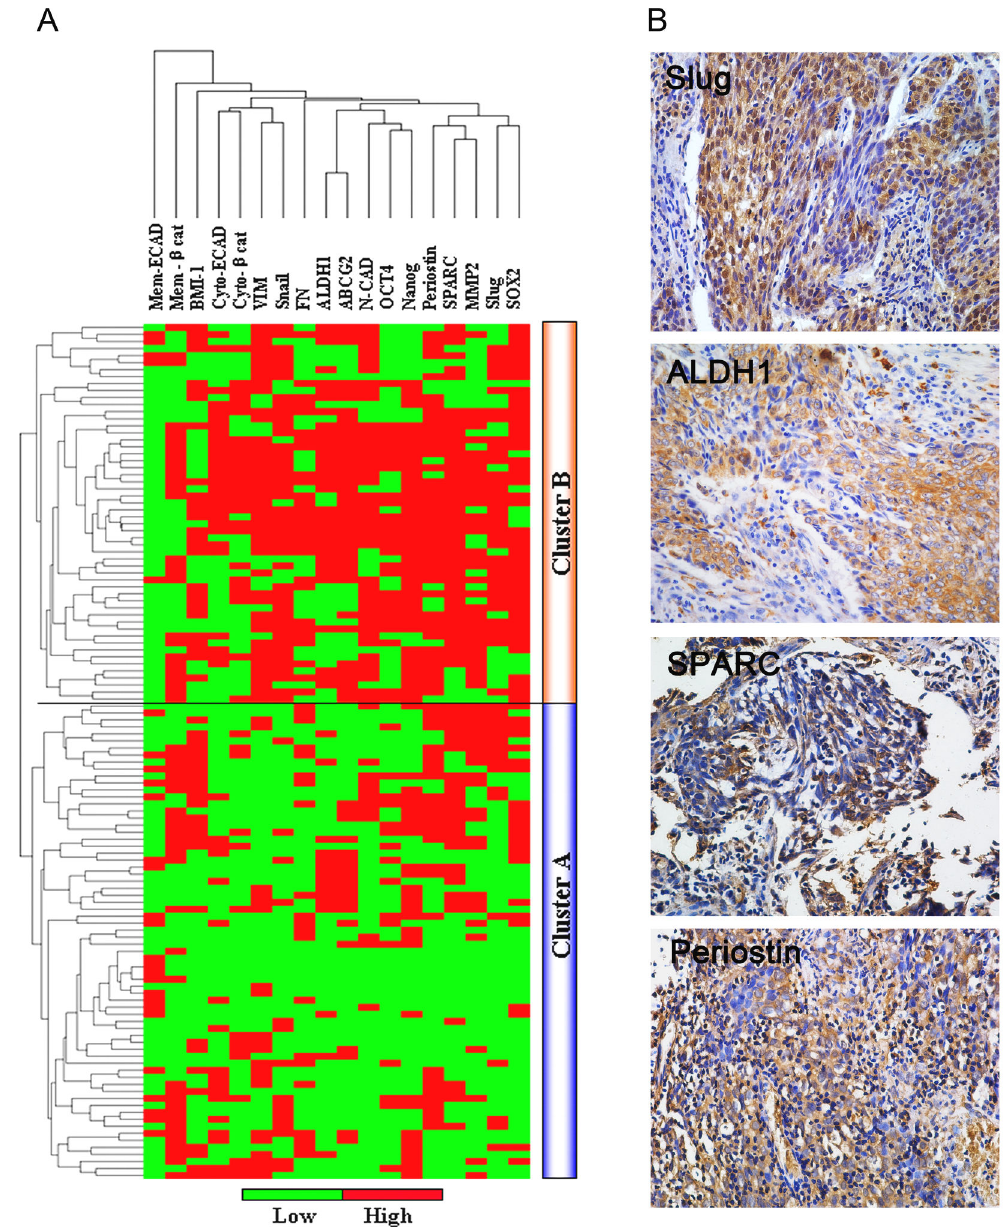
Figure 1. EMT and CSCs-associated markers are predominately expressed in the main subgroup of NPC. (A) Unsupervised clustering of 18 proteins in 122 NPC (non-keratinizing carcinoma) samples classified phenotypically distinct subgroups of tumors. Rows, experimental samples; columns, individual genes. High expression levels are in red and low expression levels in green, as indicated in the scale bar below. Tumors were divided into two major clusters (cluster A and B, segregated by a black line). Elevated expression of EMT and CSCs-related markers occurred more frequently in Cluster B than Cluster A in tumors. Of note, the majority of the tumors in cluster B displayed a spindle-shaped phenotype (≥20%). (B) Immunohistochemical staining of selected markers in tumors, especially in the spindle cells component. doi: 10.1371/journal.pone.0083135.g001 neoplastic spindle cells component (Table S3 and Figure 2A). neoplastic non-spindle cells, 79% of cases (37/47) showed In addition, Survivin overexpression was found more frequently weak or negative staining for this protein (Table S3). On the in neoplastic spindle cells (96/115, 83%). In contrast, in other hand, overexpression of EMT markers together with the